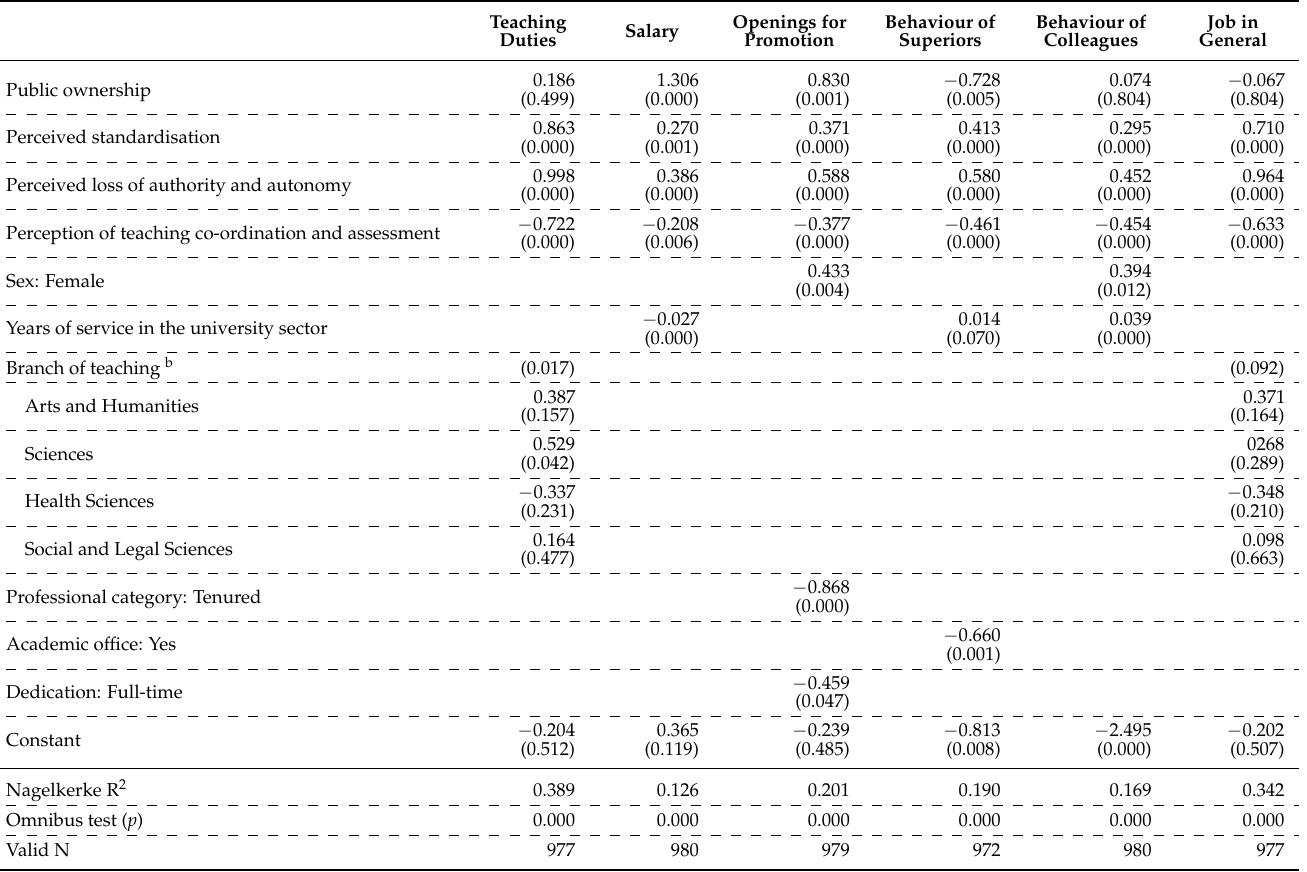
Table 5. Logit regression for the reported loss of satisfaction among academics with regard to five facets of their work and regarding work in general a